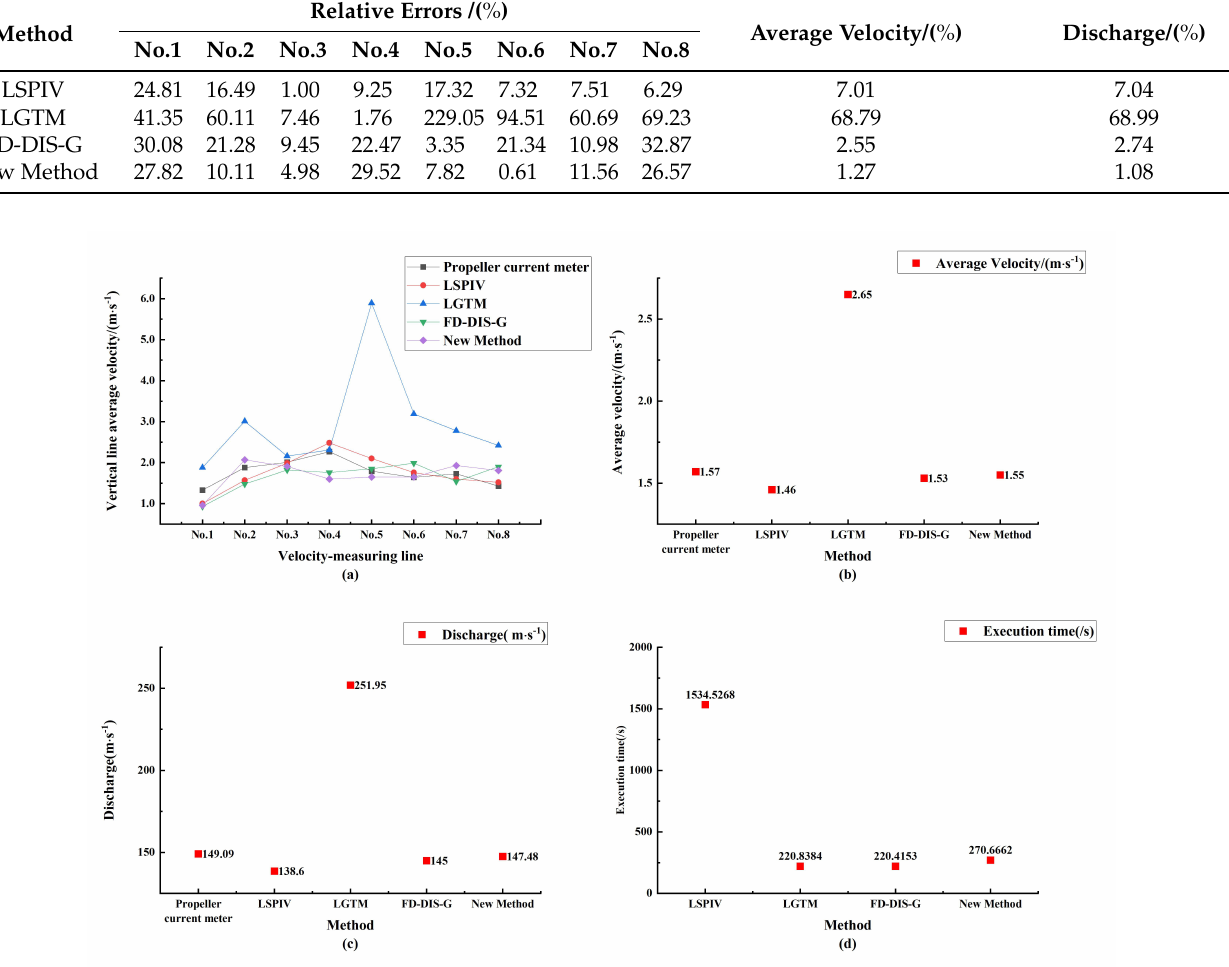
Figure 10. The results of five methods. ( a ) Comparison of vertical line average velocity; ( b )